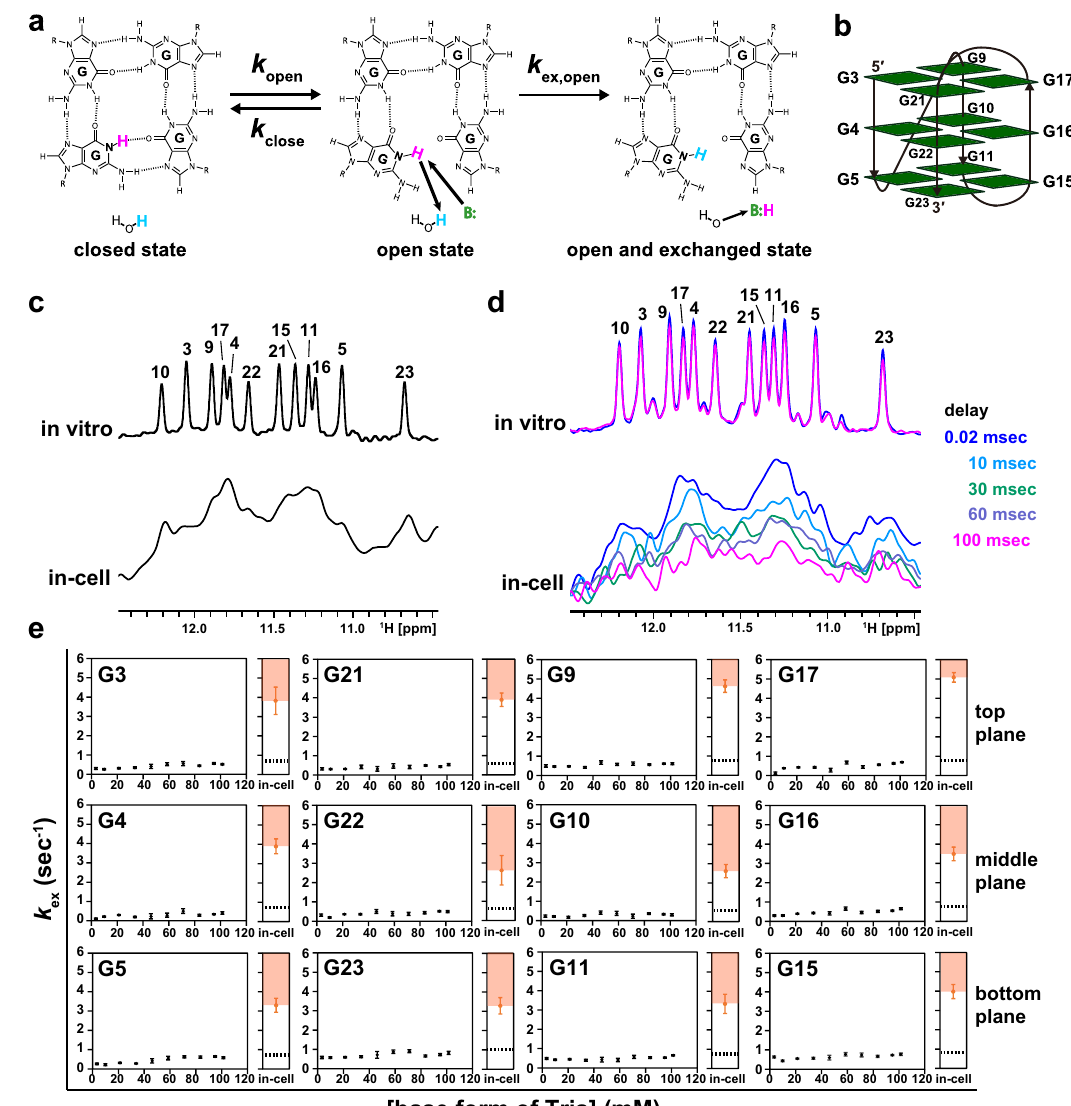
Fig. 3 | Analysis of the exchange of imino protons of the DNA G-quadruplex structure with the proton of solvent water. a Imino proton exchange reaction. b SchematicsoftheG-quadruplexstructureofteloDNA 35 .Thegreenboxesindicate guaninebases. c 1D 1 H-NMRspectraofteloDNArecordedunderinvitro(upper)and in-cell(lower)conditions. d WatermagnetizationtransferexperimentsonteloDNA were carried out under in vitro conditions, 300mM Tris (upper), and under in-cell conditionsforlivingHeLacells(lower).Spectrarecordedwithdifferentdelaytimes after water-selective inversion are superimposed. e Comparison of the deduced k open values of teloDNA between in-cell and in vitro conditions using the as a reference. For each residue, the dashed line indicates the maximum k ex value